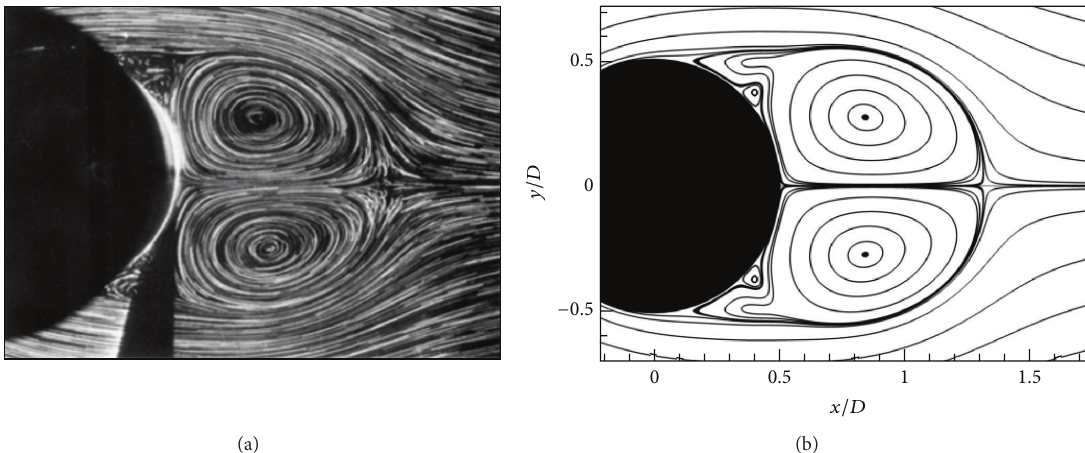
Figure 3: Comparison of the streamline patterns for Re = 550 at 𝑇 = 5.0 : (a) flow visualization by Bouard and Coutancean (1980) [17] (left) and (b) present method (right).